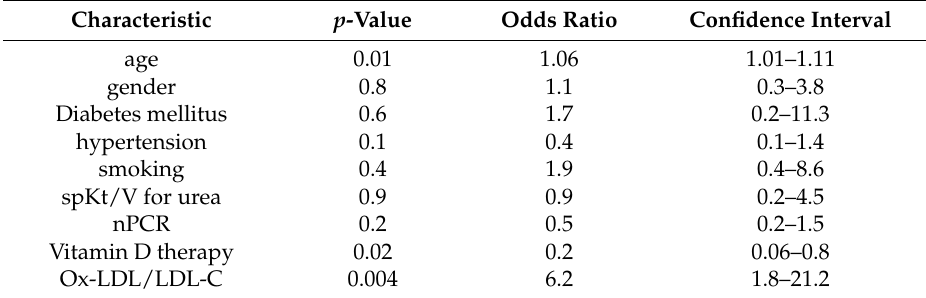
Table 3. Logistic regression analysis for the prediction of systolic cardiac dysfunction using traditional and specific risk factors for hemodiafiltration